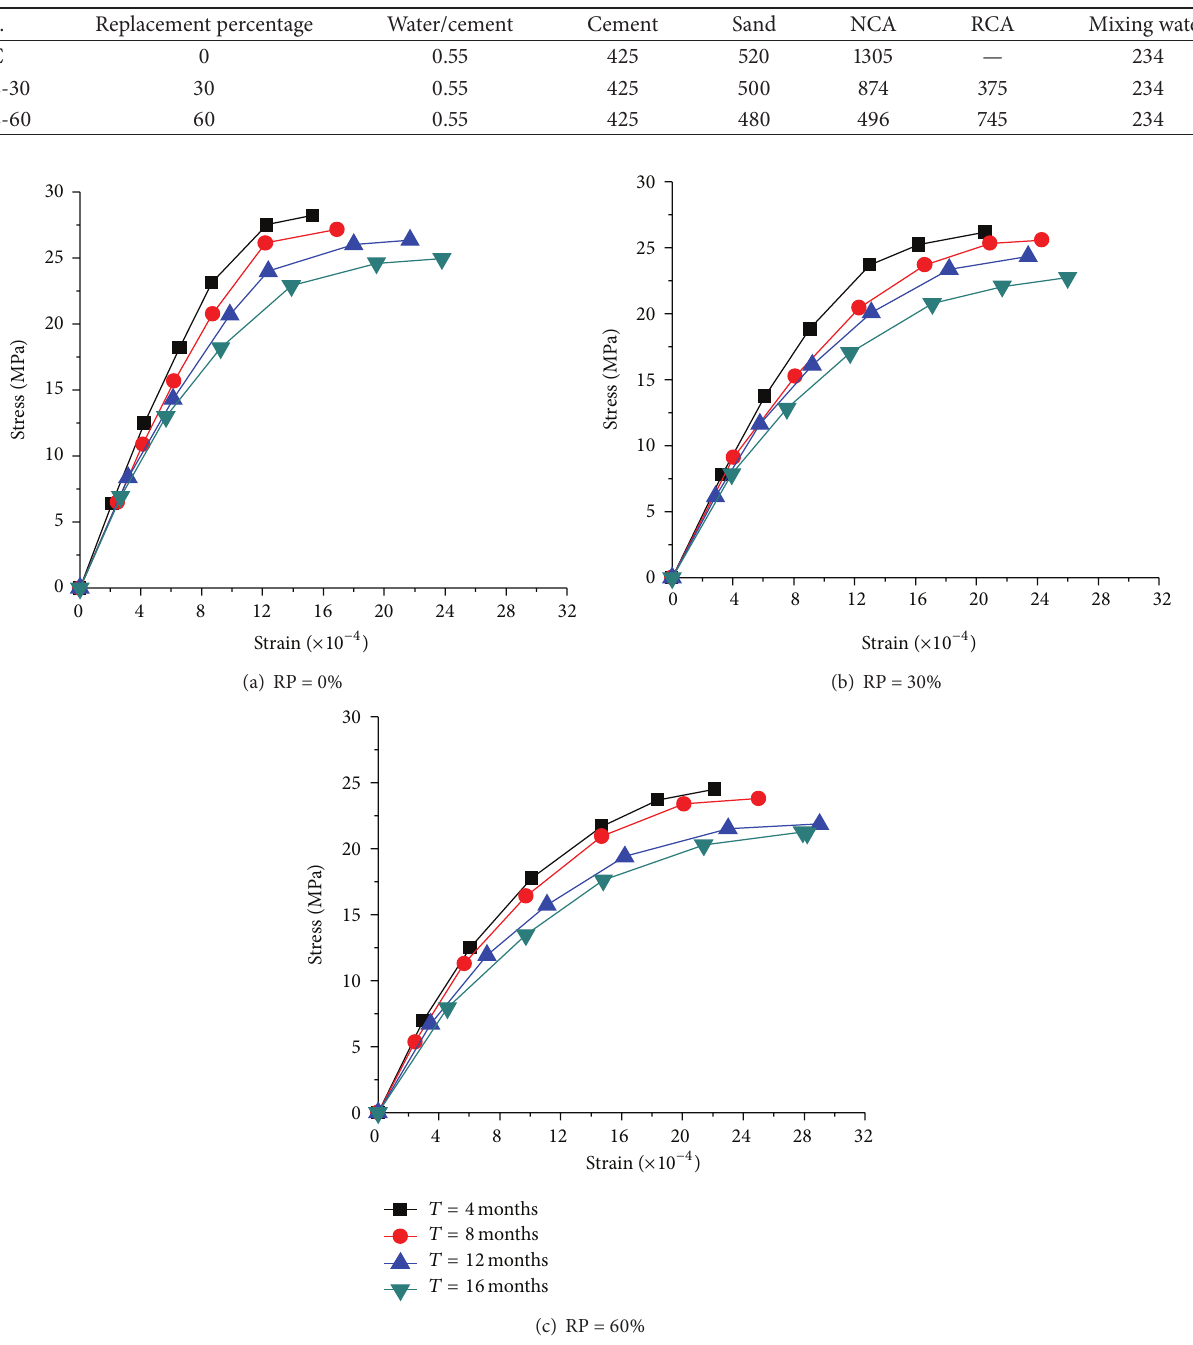
Figure 2: Typical stress-strain curves of RC in marine